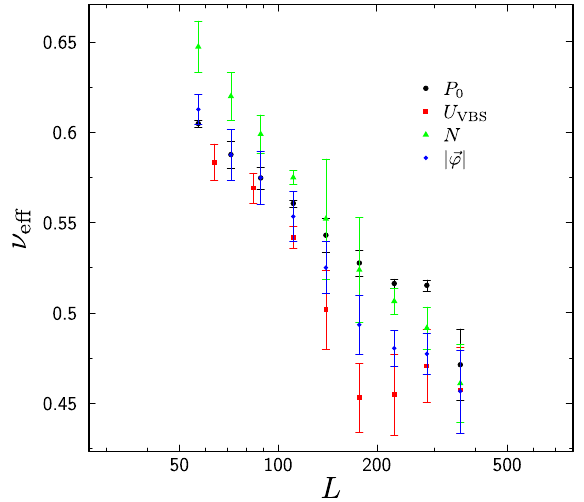
FIG. 17. Size dependence of the effective correlation- length exponent ν obtained from finite-size scaling of various eff quantities.